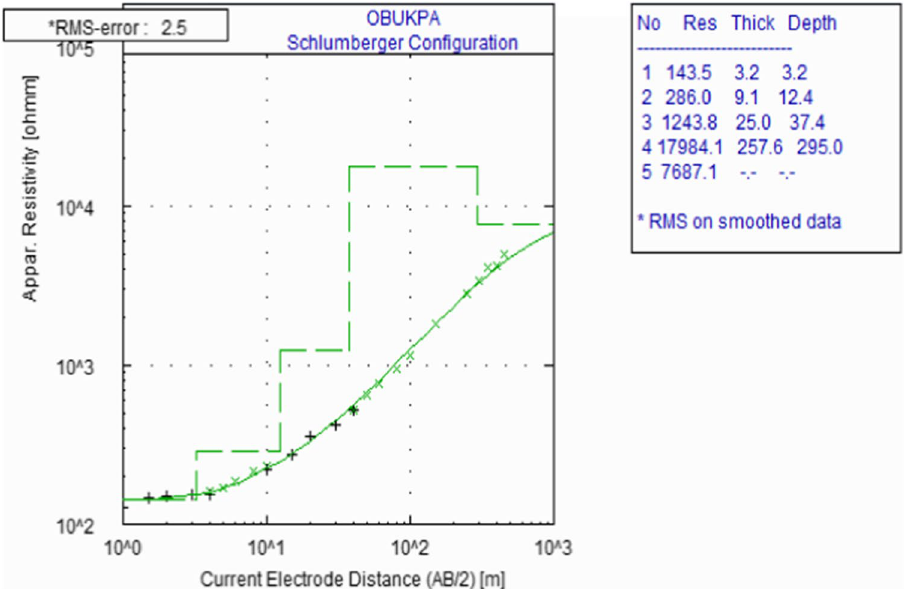
Fig. 3 Geoelectric curve for VES 7